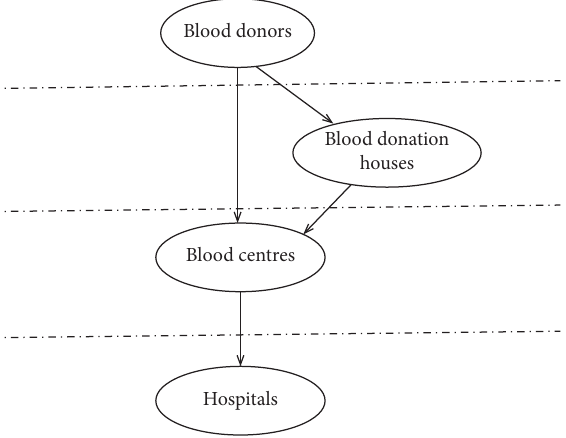
Figure 1: Operation chart of blood supply